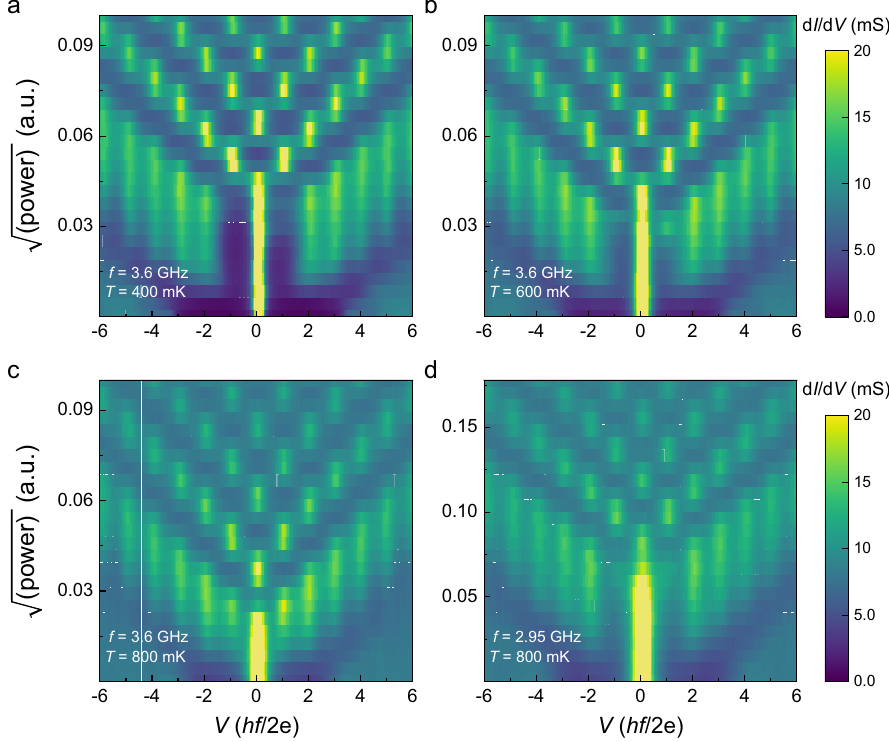
Fig. 4 Shapiro response at higher temperatures. a – d Mapping of dI / dV as functions of rf power and observed voltage for the rf excitation with 3.6 GHz ( a , b , c ) and 2.95 GHz ( d ) at higher temperatures. At 800 mK, the dc I – V characteristics is completely free from